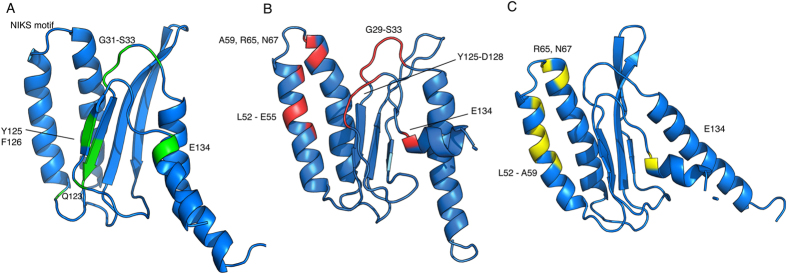
Structure of N-domain eRF1 mutants, (A) Q122FM(Y)F126 (structure derived from PDB: 2LGT) (B) Y125F (PDB: 2MQ6) and (V) E55Q (PDB:2MQ9) with the regions most affected by mutations highlighted.